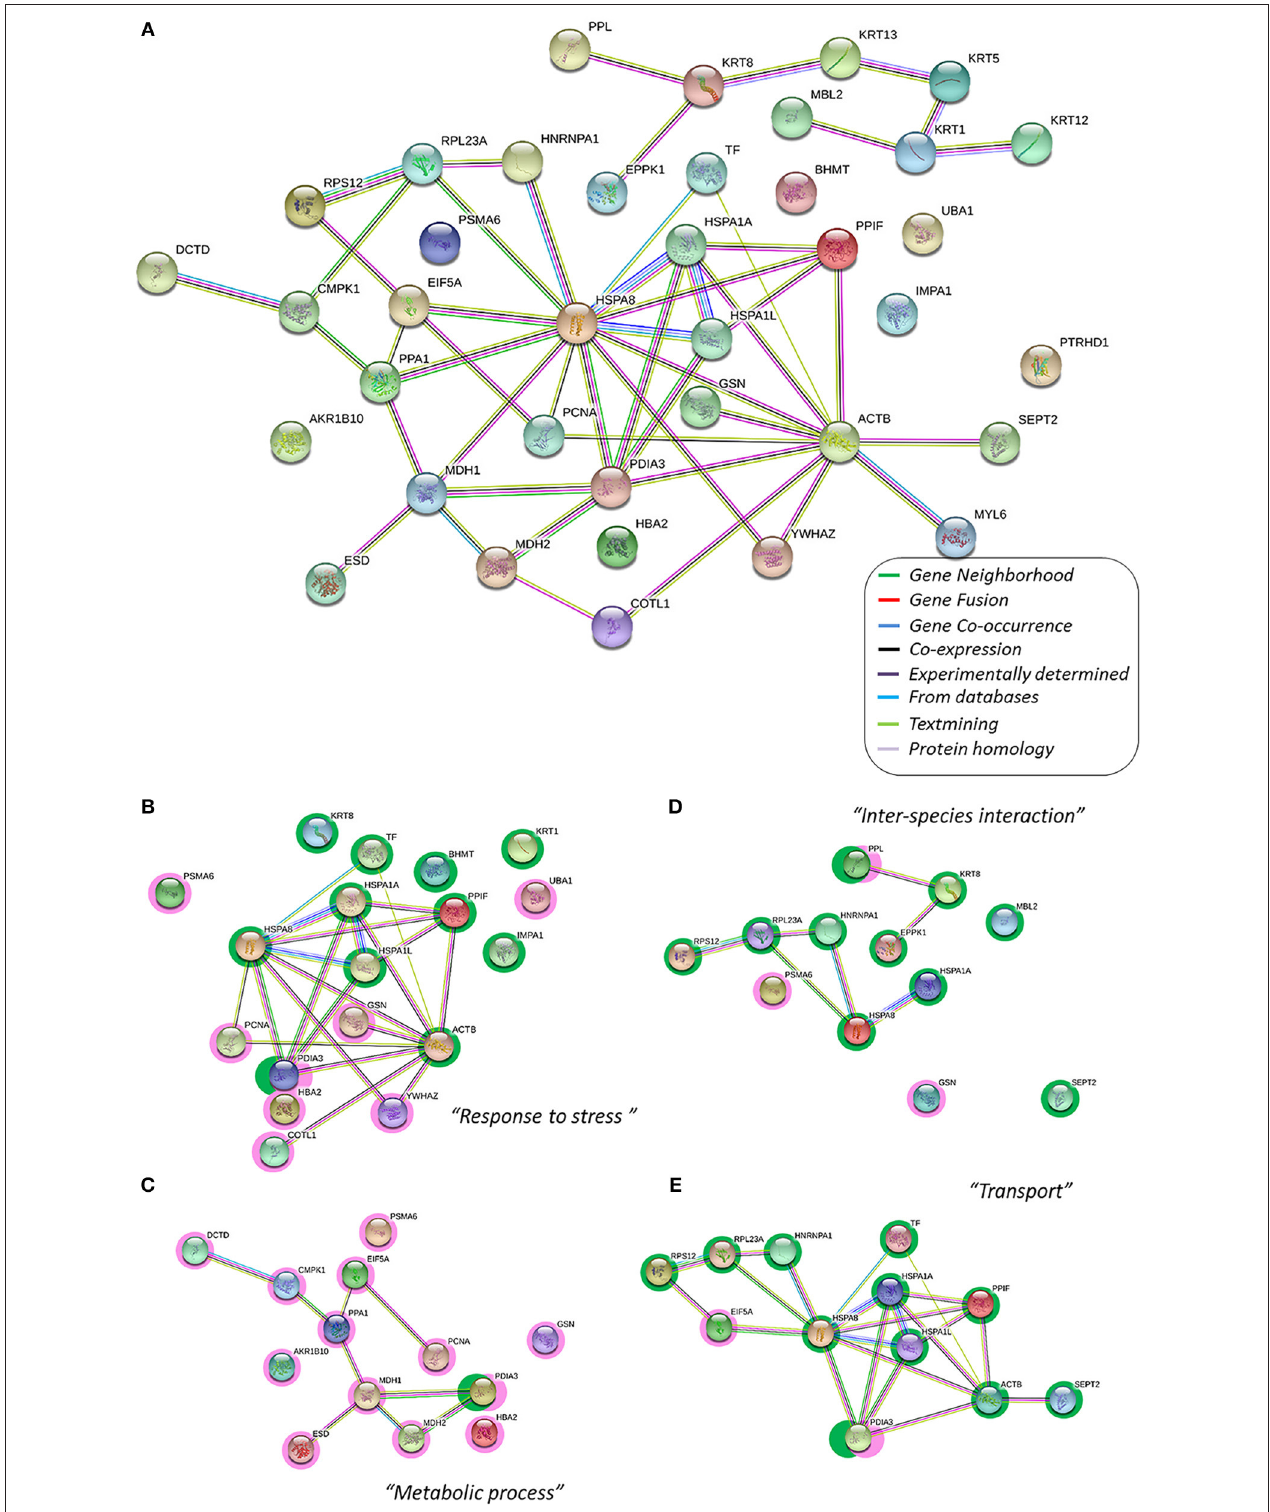
FIGURE 1 | The protein–protein interaction network, the interactome, of gilthead skin mucus proteins differentially expressed by chronic low temperatures. In this network, nodes are proteins, lines represent the predicted functional associations, and the color of the lines represents the strength of the predicted functional interactions between the proteins, according to the STRING databases (Szklarczyk et al., 2017). (A) Total protein interactome; all protein listed in Table 2 have been